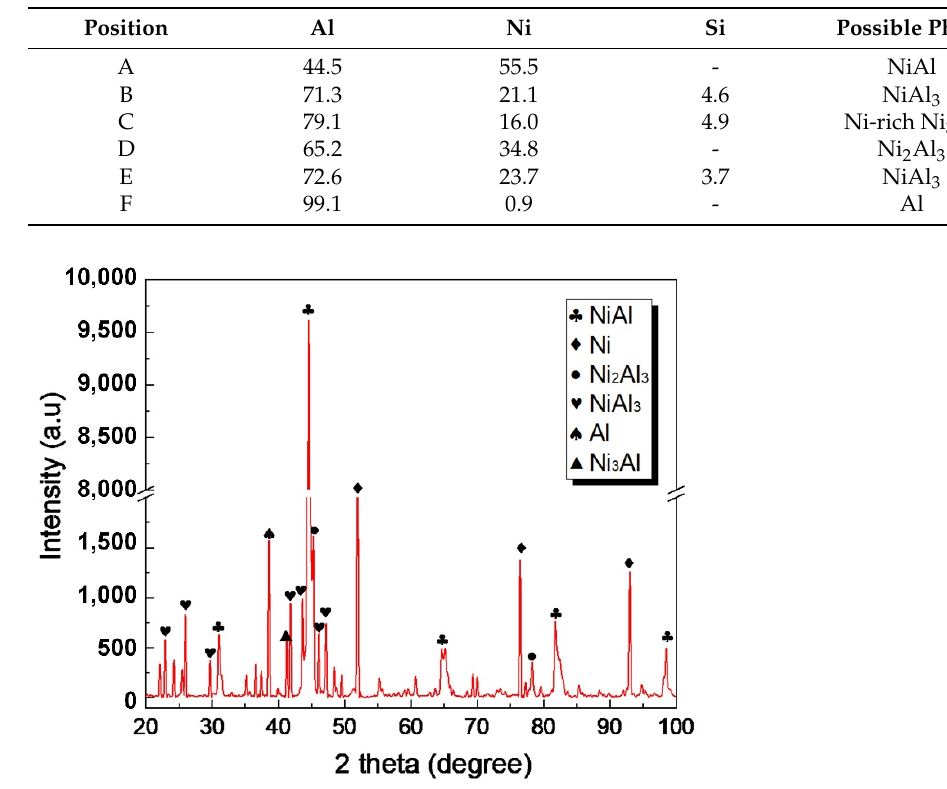
Table 1. EDS analysis results of each position in Figure 7 (at.%).